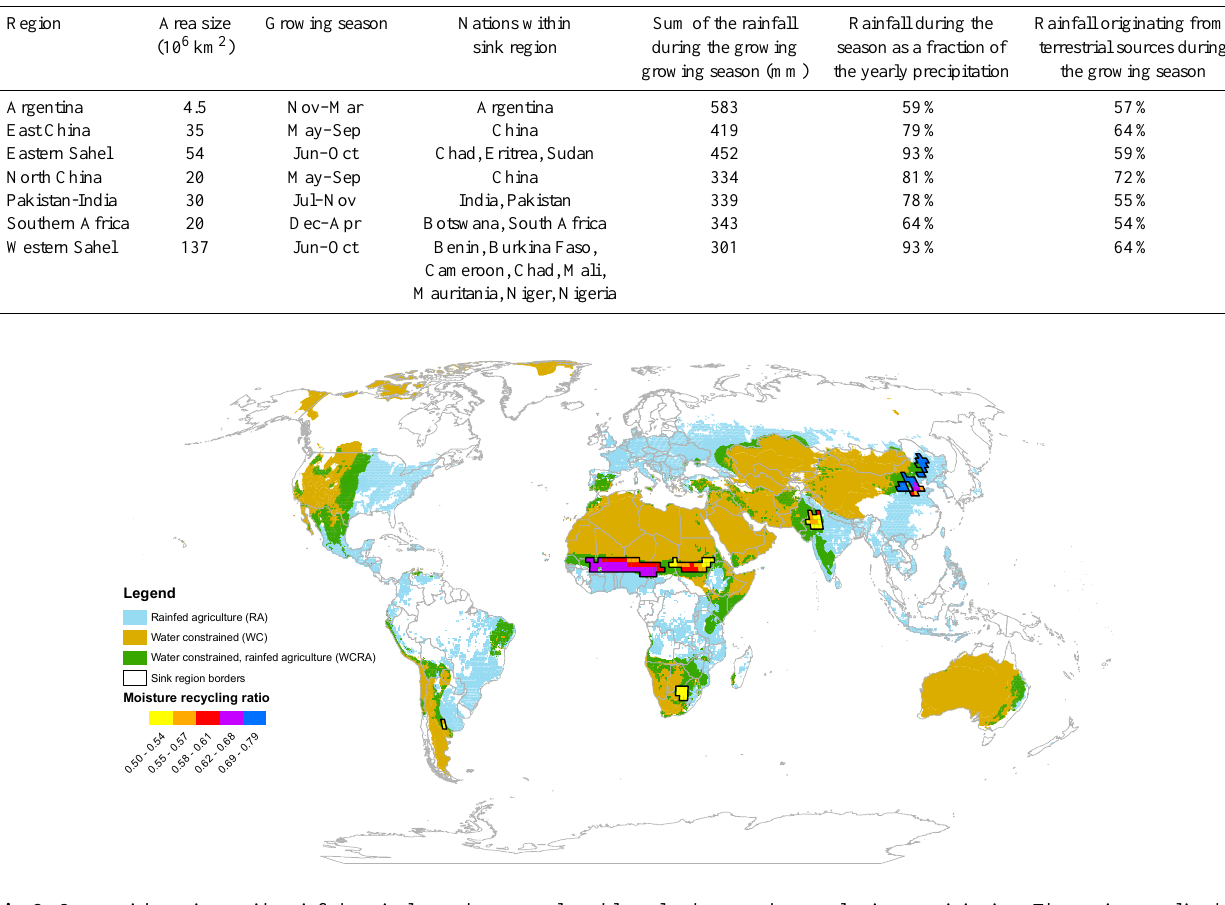
Fig. 2. Seven sink regions with rainfed agriculture, that are vulnerable to land cover change altering precipitation. The regions outlined in black are (a) located in water-constrained drylands (Portmann et al., 2010), (b) dominated by rainfed agriculture (Rockstr¨om and Karlberg, 2009), and (c) are dependent on terrestrial evaporation for more than 50% of their growing season precipitation (van der Ent et al., 2010). Note that even though the sink regions are not green (which would indicate they are a WCRA region), they are in fact all water-constrained and dominated by rainfed